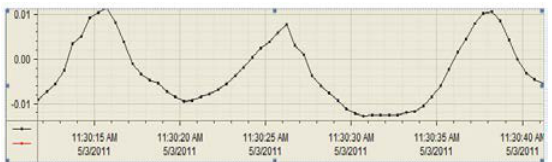
Figure 15. Payload vertical position during load case